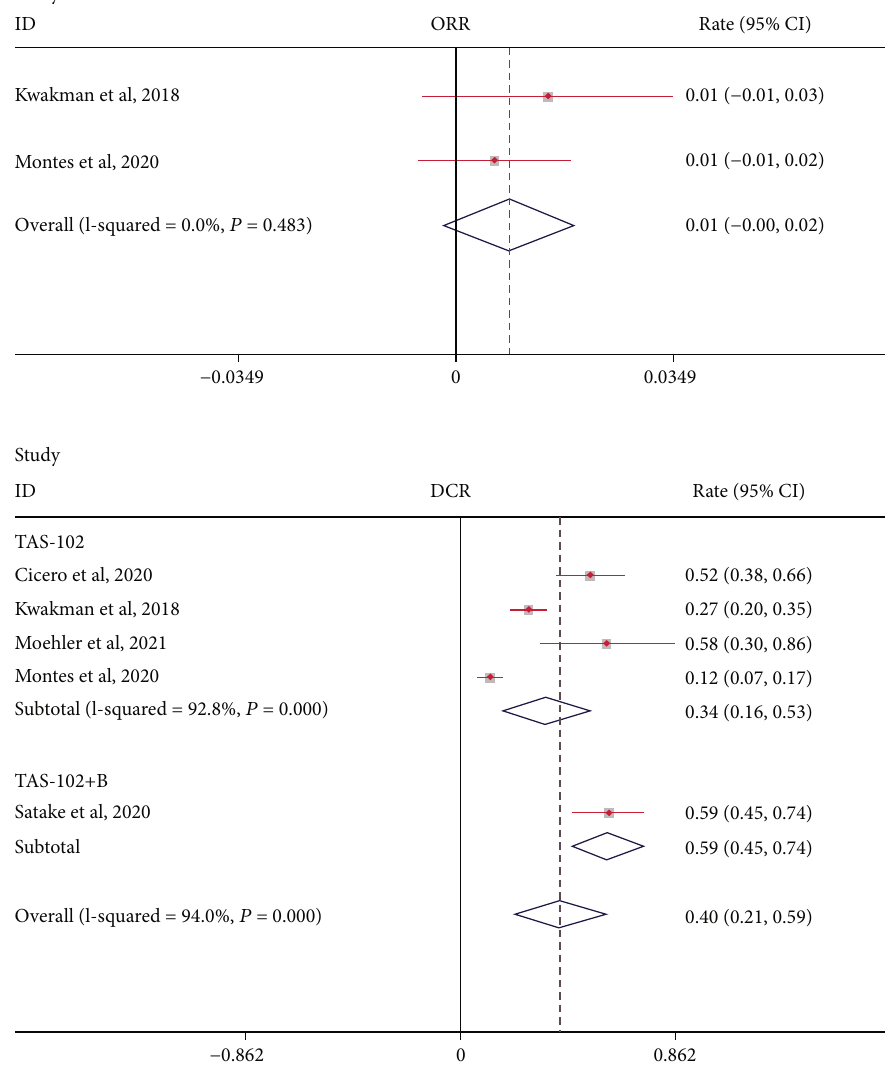
Figure 2: Objective response rate (ORR) and disease control rate (DCR) of TAS-102 monotherapy or combination therapy with bevacizumab for metastatic colorectal